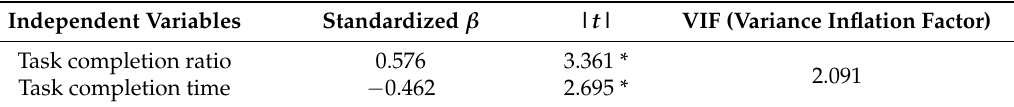
Table 7. Result of multiple regression analysis.